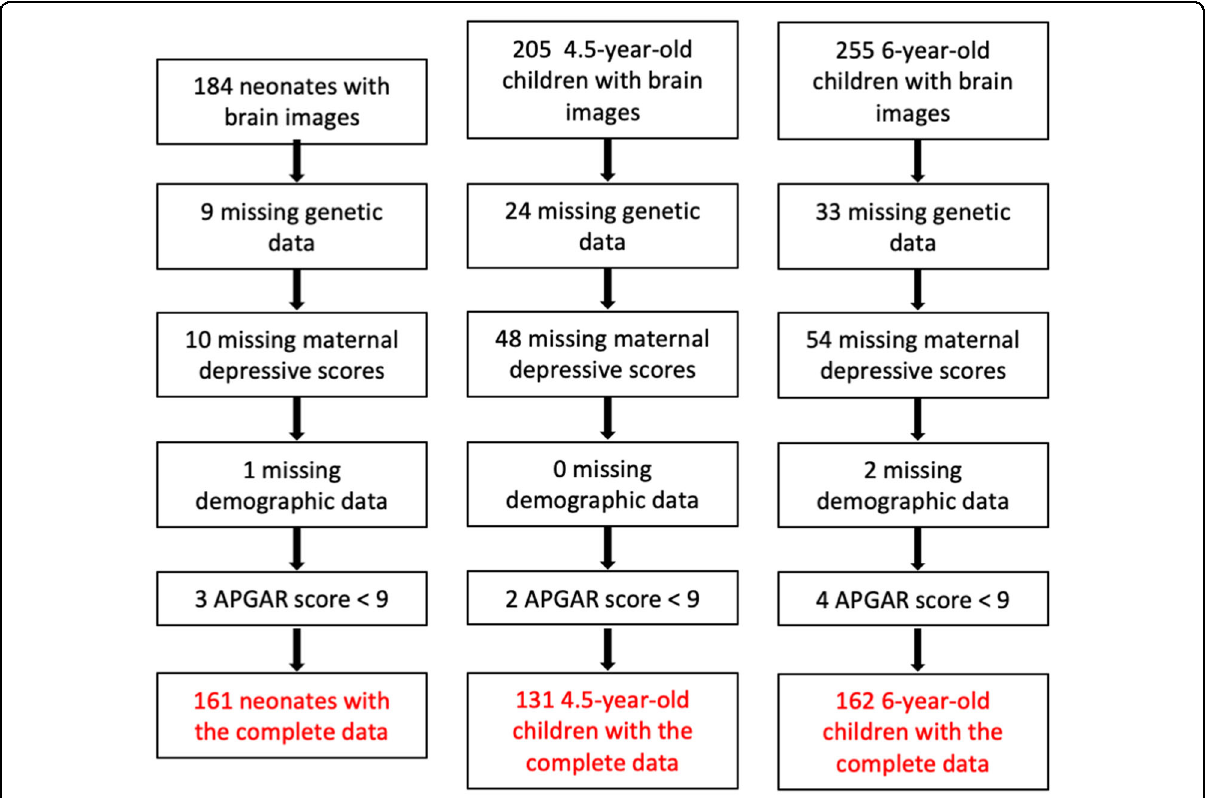
Fig. 2 Subject selection. Flow chart of the subject